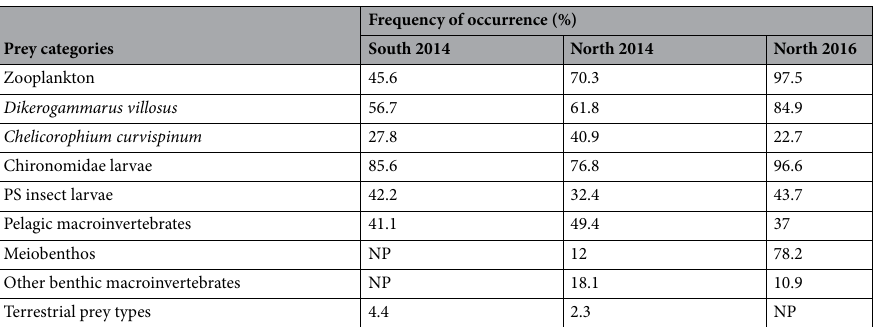
Table 2. Frequency of occurrence (%) of prey categories in the diet of YOY perch ( Perca fluviatilis ) from two sampling sites of Lake Müggelsee (“South” and “North”) in 2014 and 2016. Zoopankton: cladocerans and copepods; pelagic macroinvertebrates: Chiromonidae and Culicidae pupae; predator-sensitive (PS) insect larvae: Ephemeroptera and Plecoptera; meiobenthos: Ostracoda and Harpacticoids; other benthic macroinvertebrates: snails and leeches; terrestrial prey types: adult stages of Ephemeroptera, Odonata and Trichoptera. NP not present.